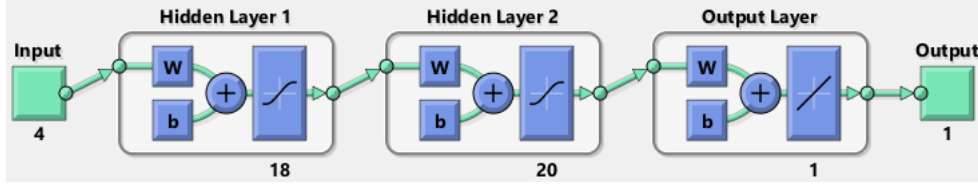
Figure 7. Optimized neural network structures for predictor of the RW_WSB performance.